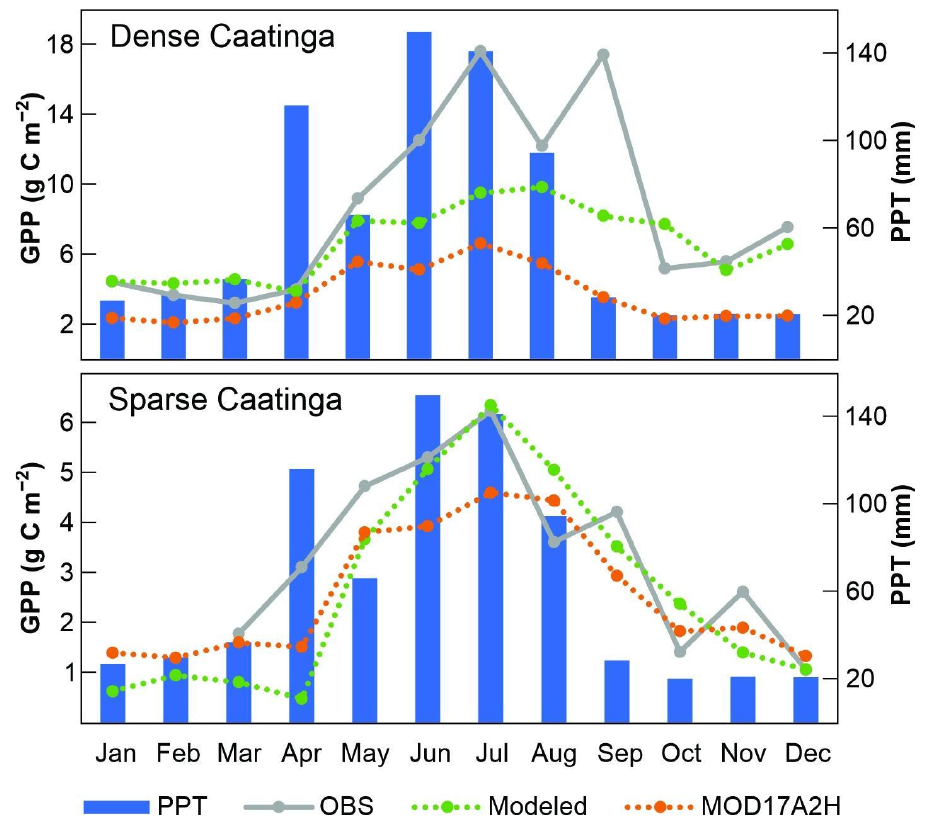
Figure 3. Monthly temporal distribution of GPP in the areas of DC and SC in 2013.